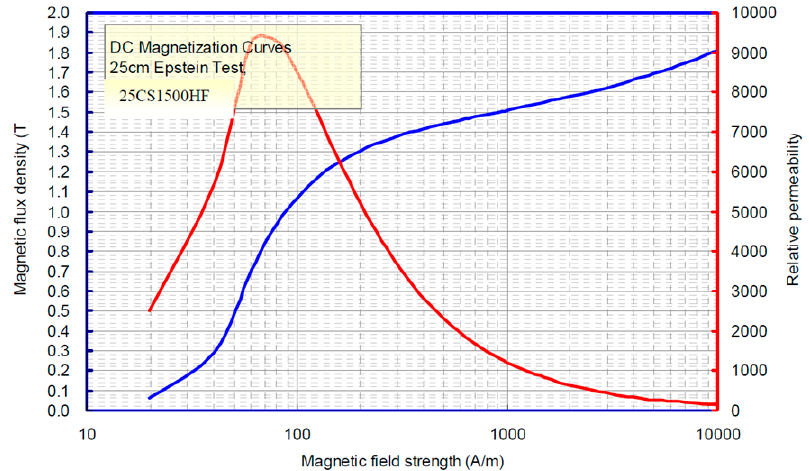
Figure 22. B-H curve of steel material.